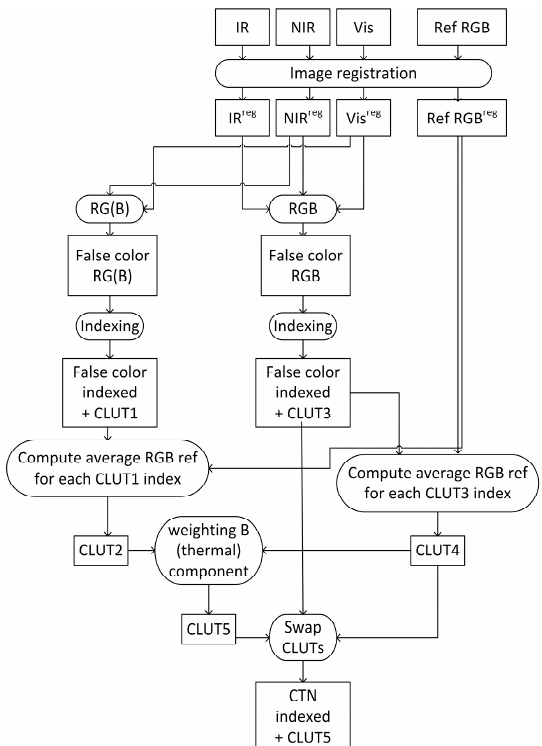
Figure 8. Processing scheme of the SHT sample based color fusion method.